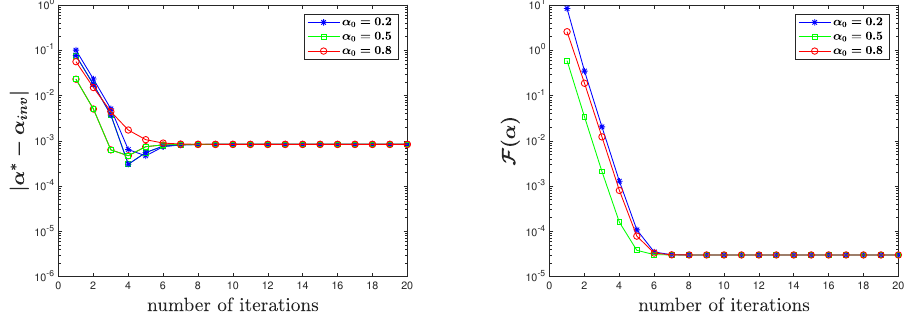
Figure 9. α ∗ = 0.6 for uncontaminated observation data in Test 3.